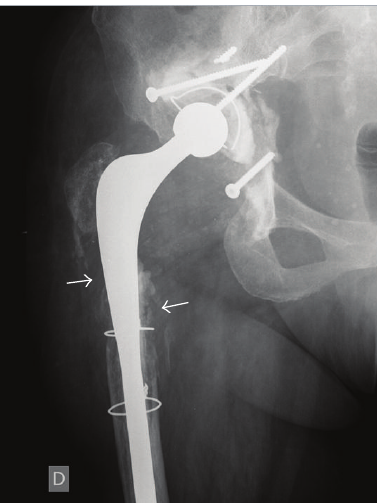
Figure 3: X-ray of total hip arthroplasty showing extensive lytic lesions around the femoral component (arrows), indicating infec- tion.